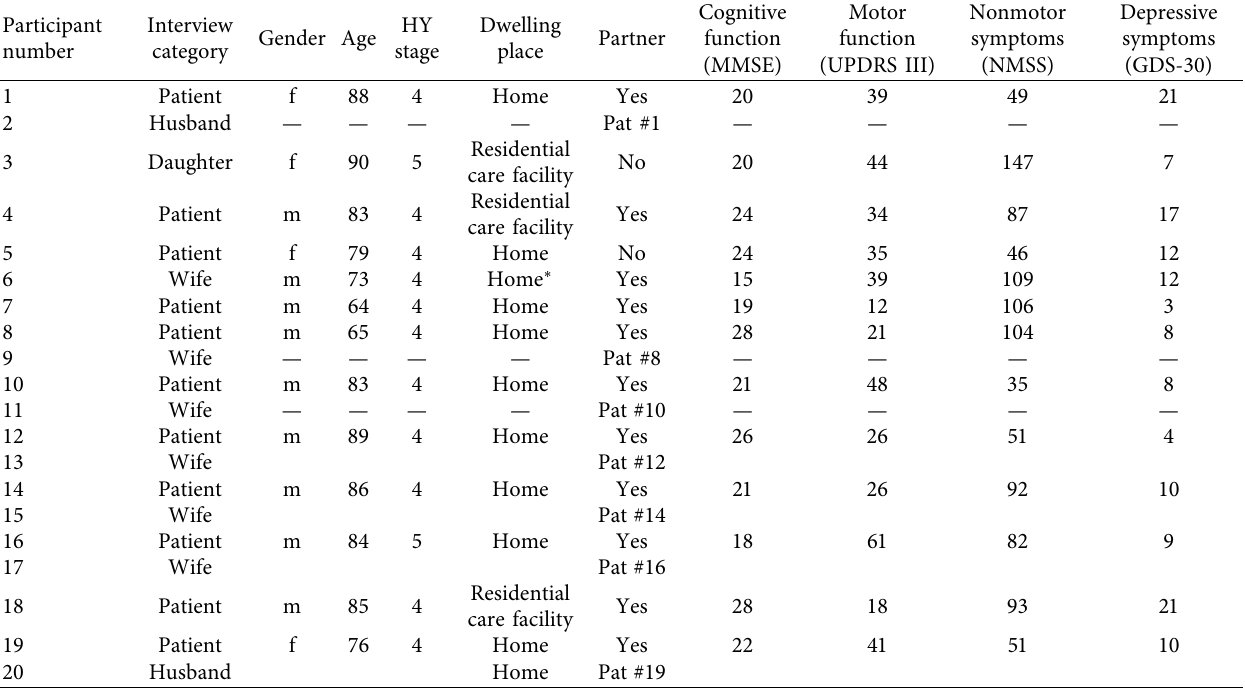
Table 1: Participants’ characteristics qualitative interview study, n �